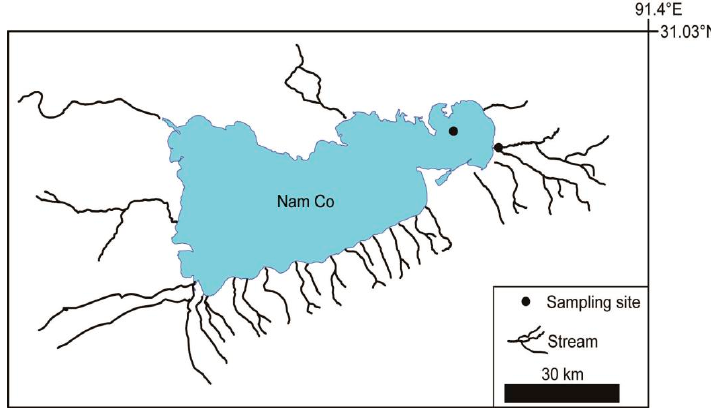
Figure 1. Location of Lake Nam Co and the sampling sites.